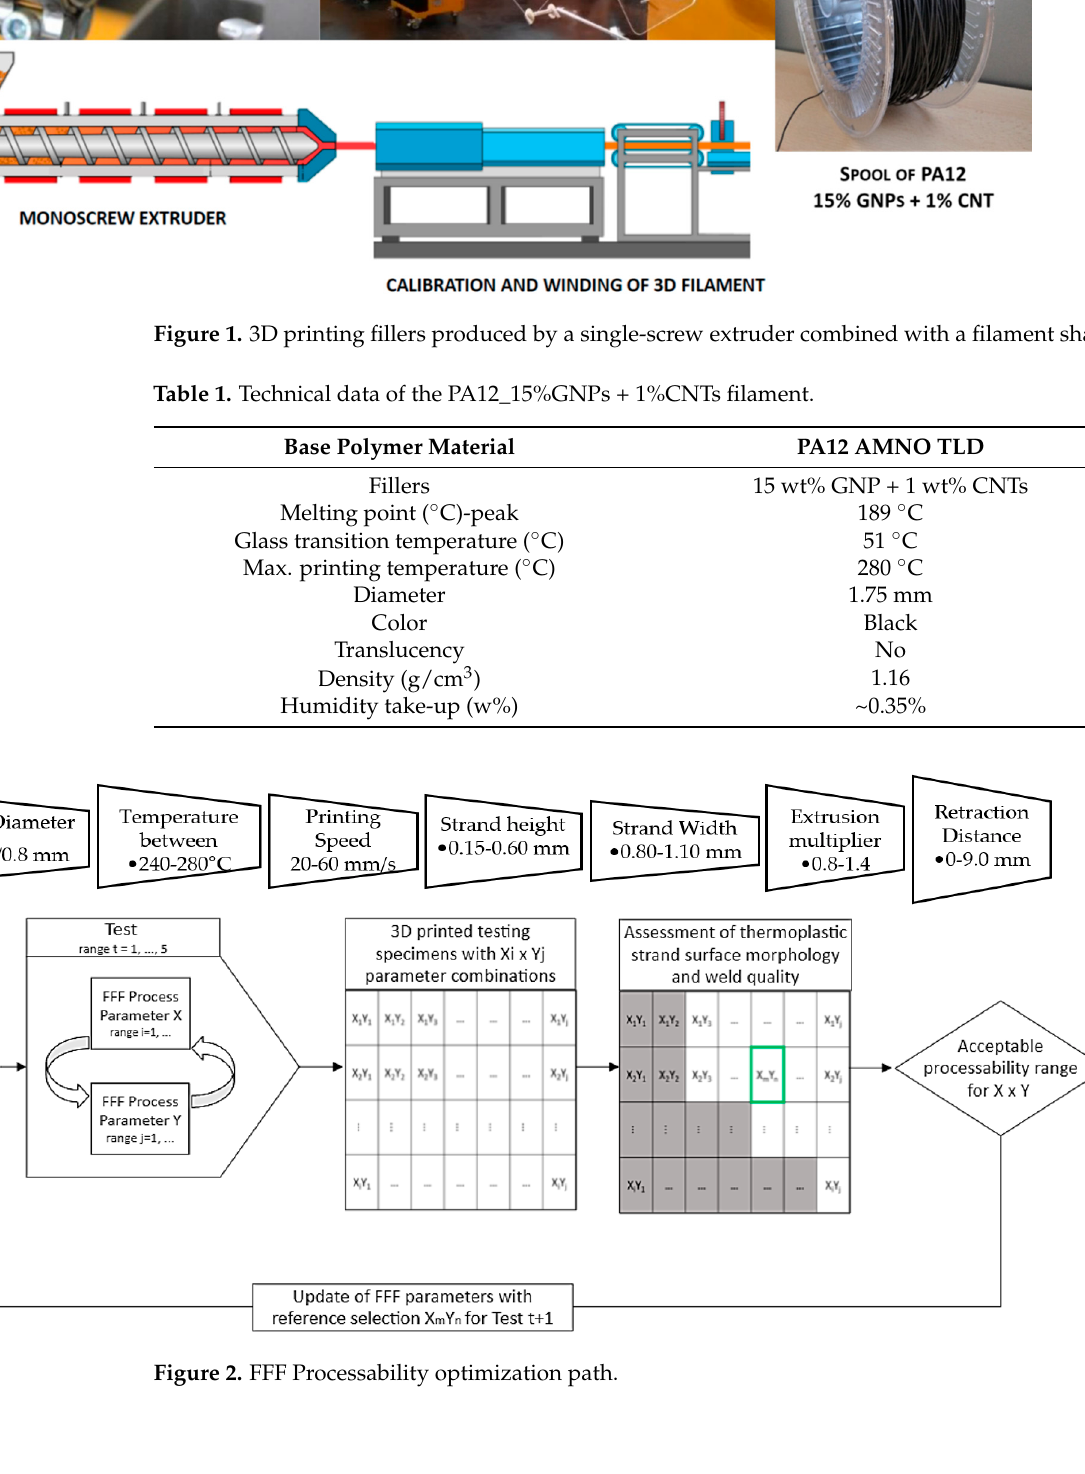
Figure 1. 3D printing fillers produced by a single-screw extruder combined with a filament shaper.